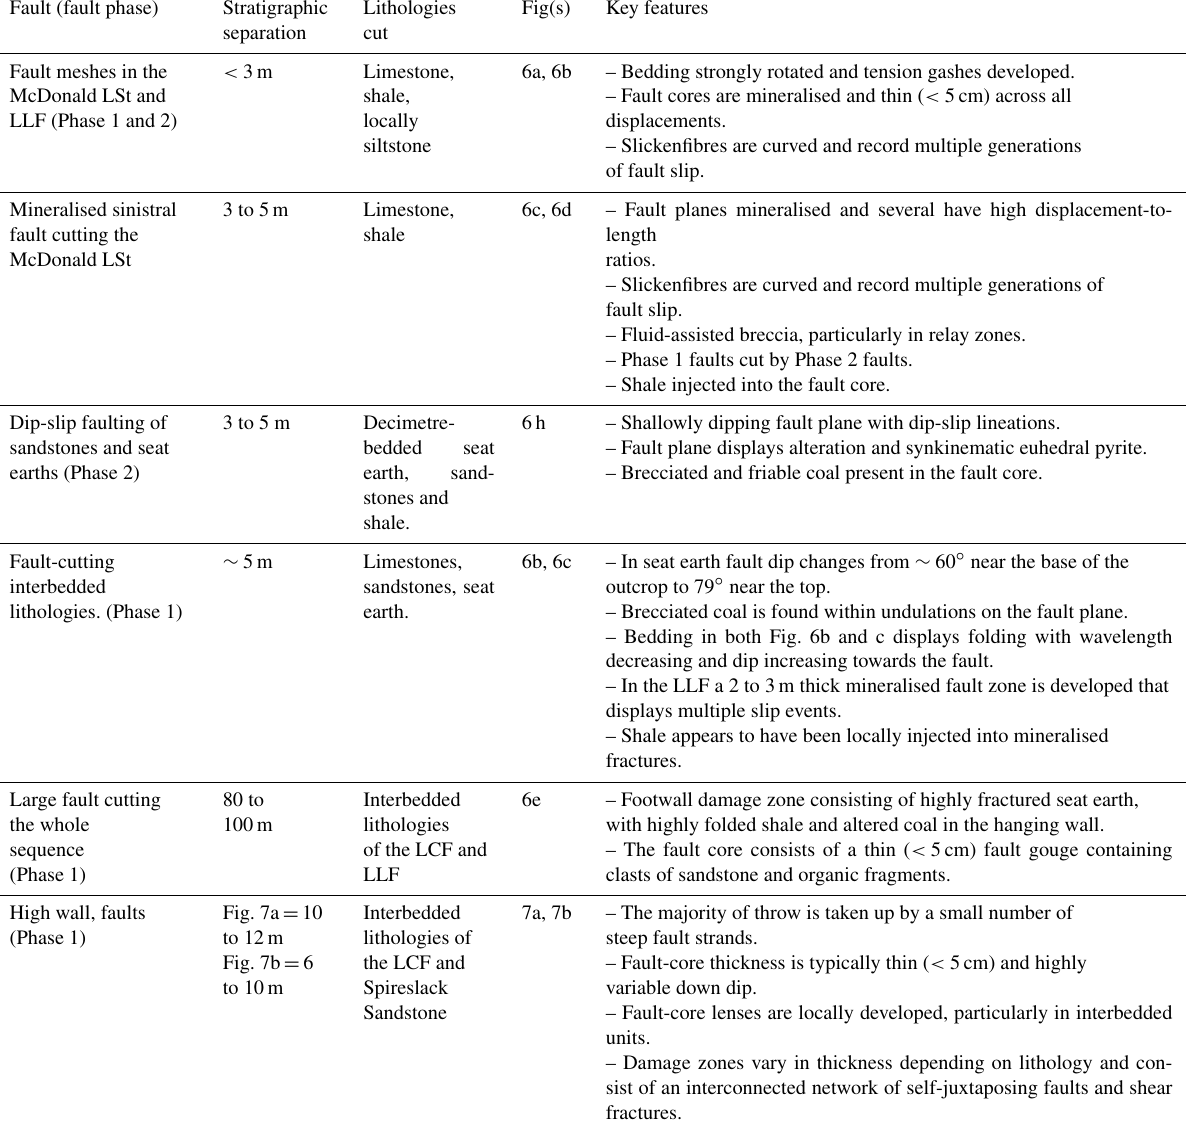
Table 2. Summary of the key features observed along faults that juxtapose multiple lithologies. Please see S3 for full field descriptions. LLF stands for Lower Limestone Formation, and LCF stands for Limestone Coal